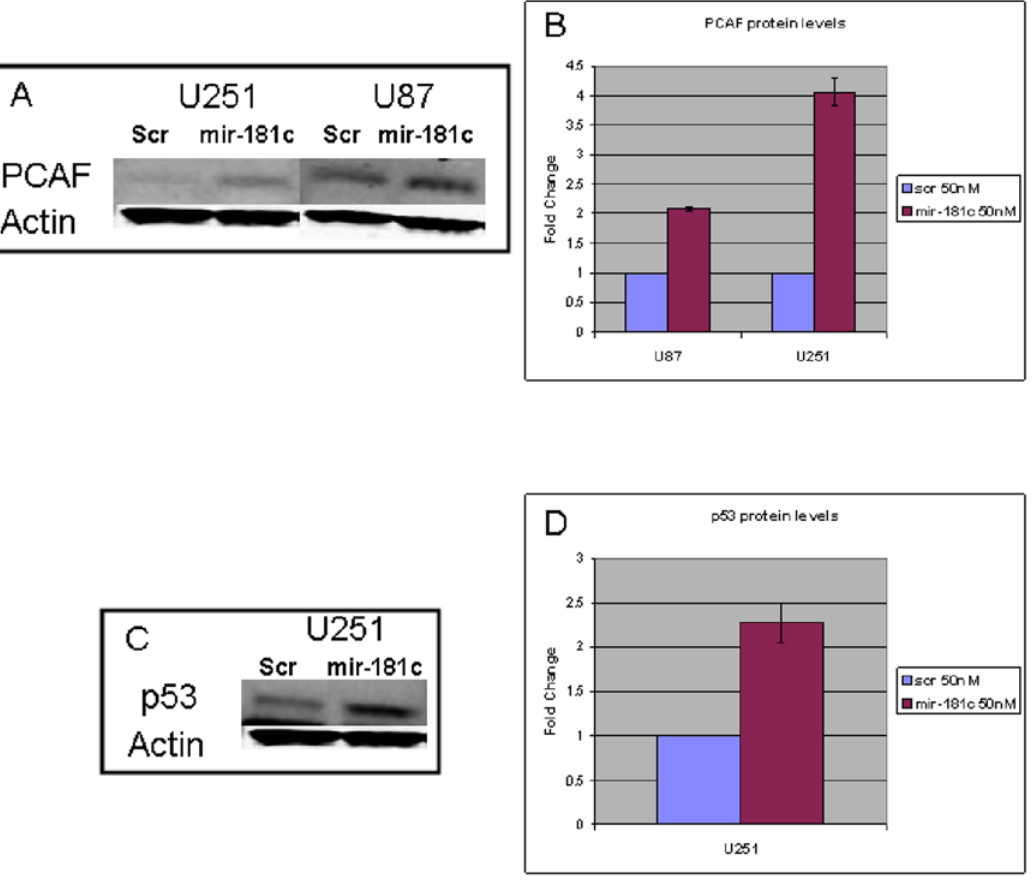
Figure 6. Immunoblot analysis of miR-181ctreated cells. Immunoblots of U251 and U87 transfected cells transfected with either miR-181c pre- miRNA or a scrambled sequence. PCAF (A) and p53 (C) were immunodetected and actin was used as a loading control. Quantification of the immunoblots showed a significant difference in B and C (p , 0.01, t-test in all three comparisons).